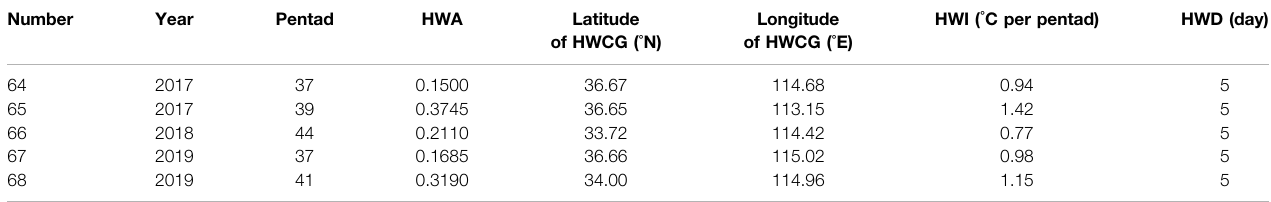
TABLE A2 | ( Continued ) Same as Table A1 , but for RPHWs in